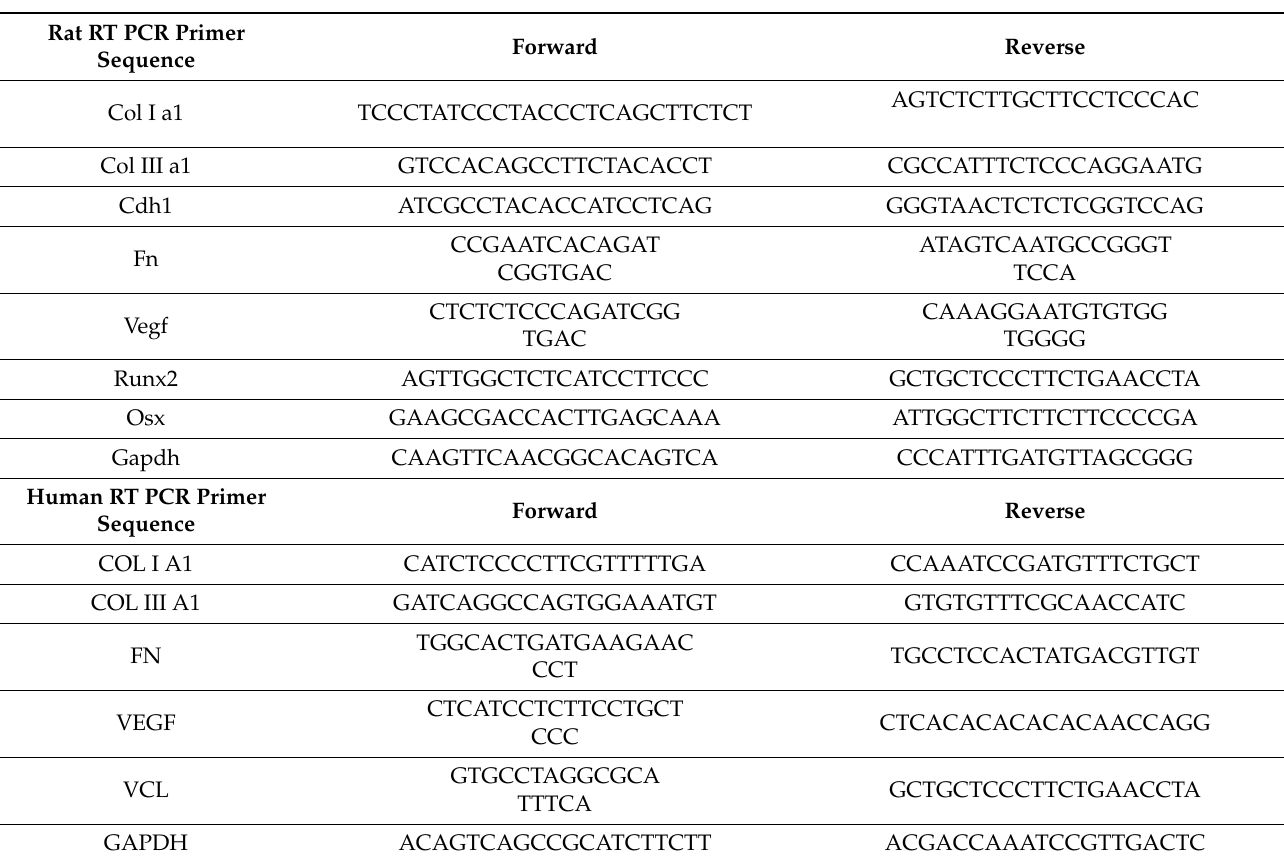
Table 1. RT-PCR primer